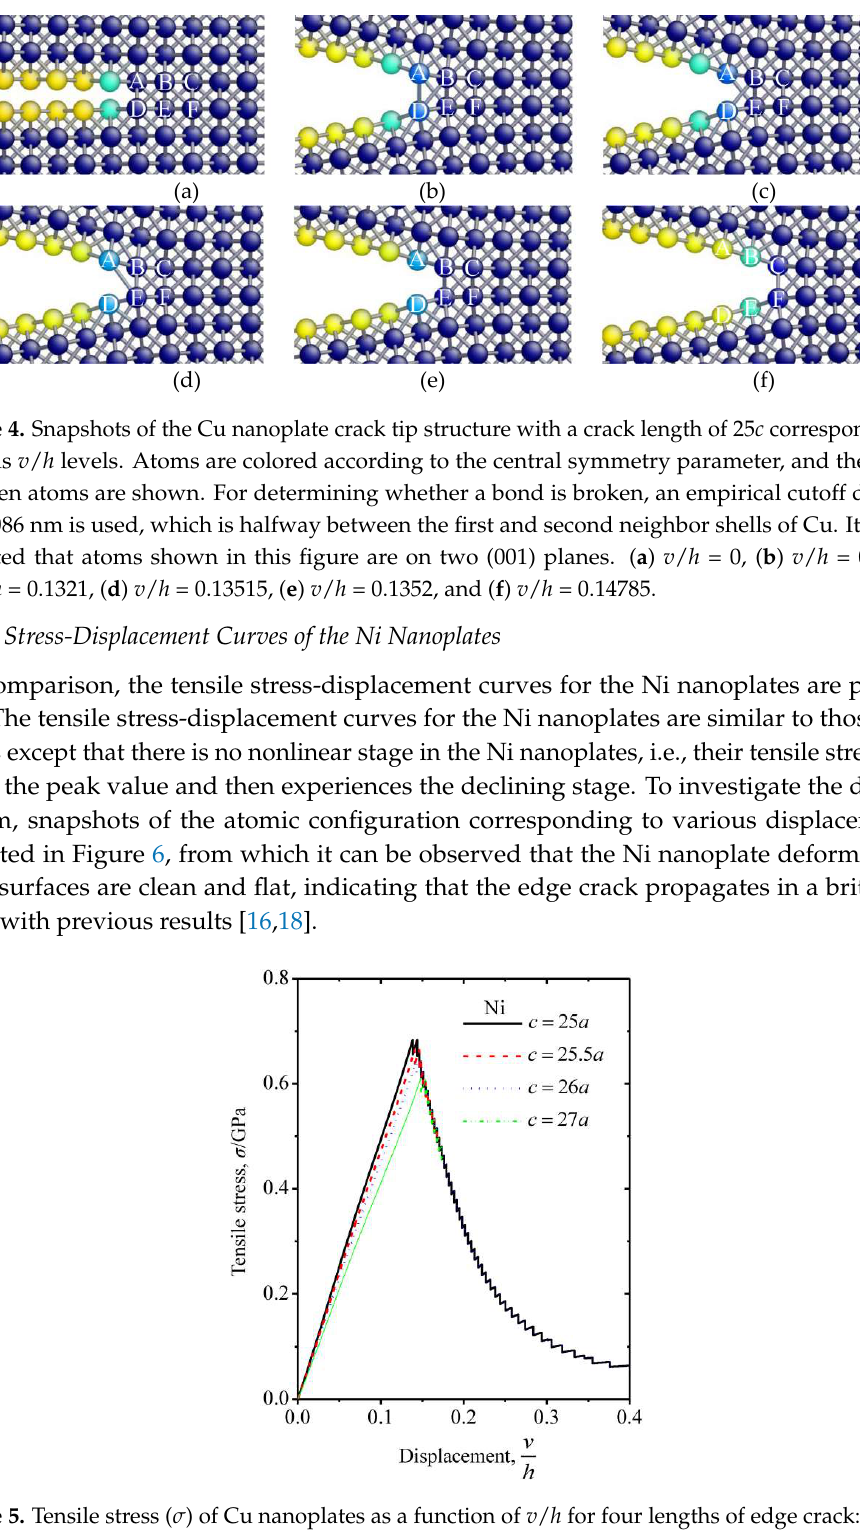
25.5 a , 26 a , and 27 a .   is defined as the average value of the atomic stress (  22 ) over the entire volume